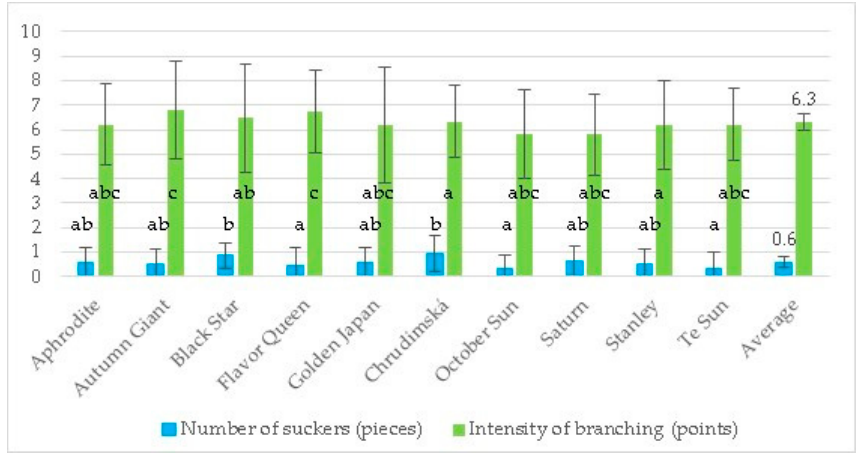
Figure 3. A comparison of the average affinity and yield of saplings, by variety used. Small letters indicate statistically different homogeneous subgroups.